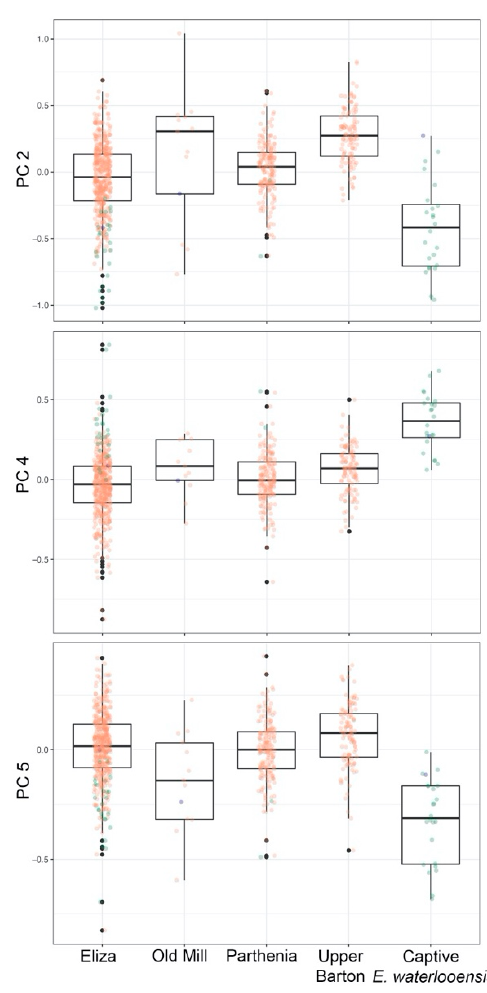
Figure 5. Boxplots of principal component (PC) factor scores across different axes showing variation in wild salamanders among spring outflows of Barton Springs as well as for captive Eurycea waterlooensis . Salmon symbols represent E. sosorum , and teal symbols represent E. waterlooensis . For visualization purposes, we presented values for both species; however, we excluded individuals of E. waterlooensis from the statistical analysis of microgeographic variation in E. sosorum (see text). Table 1. MANOVA of effects of season, locality, and centroid size (covariate) on head shape variables (i.e., first five principal component factor scores) for Eurycea sosorum .